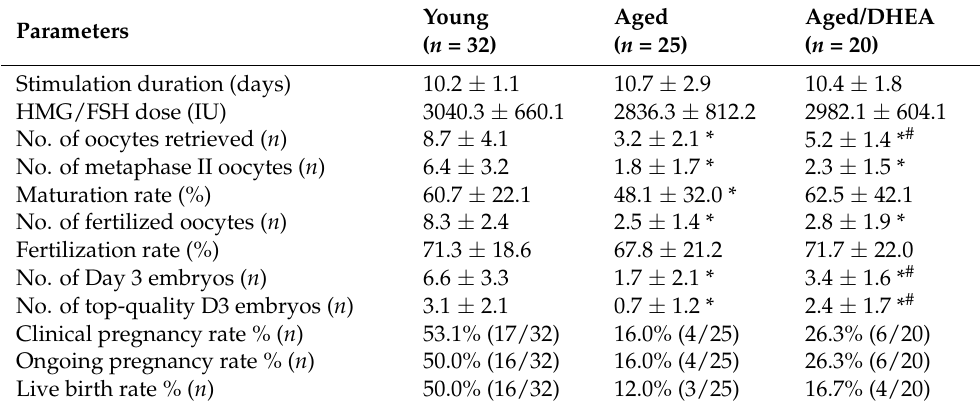
Table 2. Cycle characteristics and pregnancy outcome in the young, aged, and aged/DHEA groups.